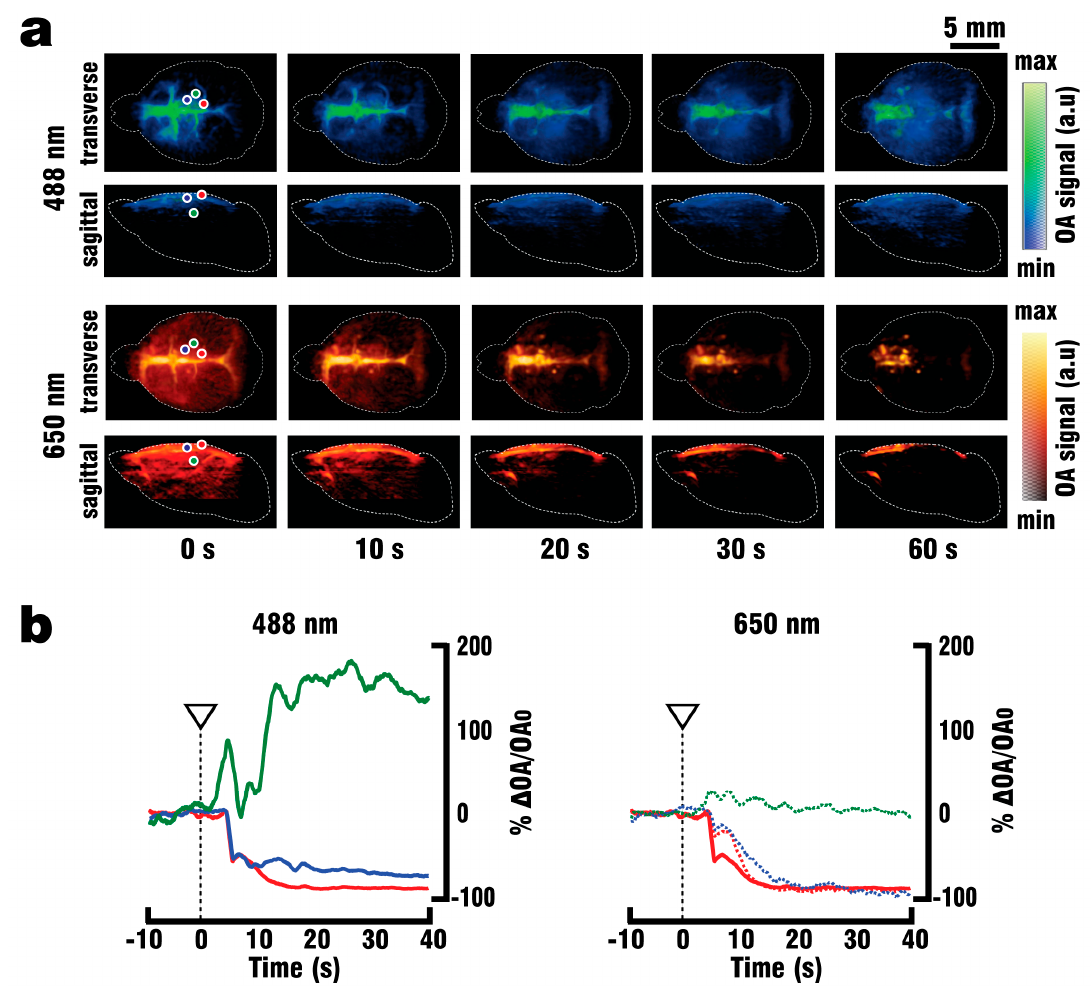
Figure 2. Recorded signal changes during cardiac perfusion ( a ) Volumetric FONT images of a GCaMP6f-labeled brain during the blood clearing process. Sixty seconds after start of the cardiac perfusion, signals from vessels diminished while signals deeper in the brain could be detected with 488 nm excitation. Red dot—Vessel; Blue dot—Cortex; Green dot—Hippocampus. OA: optoacoustic ( b ) Time-traces of the normalized FONT data recorded during the clearing procedure along with the moving averages over 10 images are shown from volumes of interest indicated in panel A with the corresponding colors. Following 40 s of perfusion, blood vessels (red) lose nearly all of their signal strength at both wavelengths as blood is removed. In a cortical area at 0.3 mm depth (blue) >98% of the 650 nm and ~80% of the 488 nm signal diminishes following perfusion, indicating the separation of the GCaMP signal component from the blood background. In a deeper brain area at 1.5 mm (green), a strong increase in GCaMP-related 488 nm signal was detected following perfusion, indicating that blood removal increases the maximum observable depth.